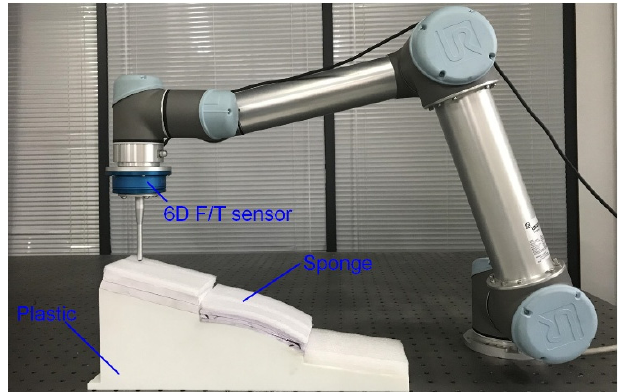
Figure 8. Experimental platform when executing ( a ) force tracking on a sloped surface and ( b ) force tracking on curved surface, and ( c ) when grinding.